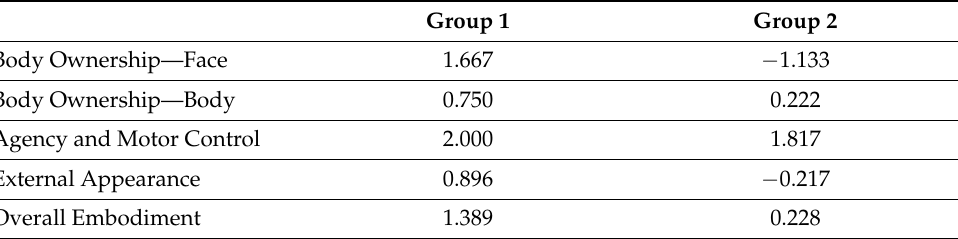
Table 6. The mean scores of embodiment, calculated according to Gonzalez-Franco and Peck [13] based on the embodiment questionnaire (scale from − 3.0 to 3.0).